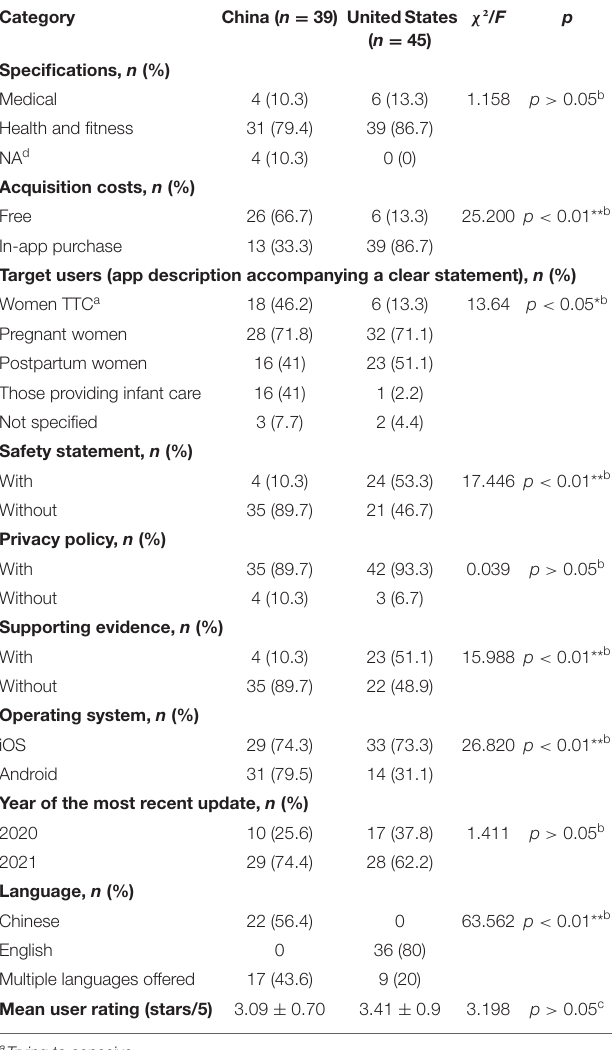
TABLE 1 | Characteristics of the 84 apps for pregnancy to postpartum care identified in the US–China comparison. physical activity during pregnancy ( n = 6, 15.4% in China vs. n Category China ( n = 39) UnitedStates ( n = 45) (3) general education: nutrition knowledge during pregnancy ( n